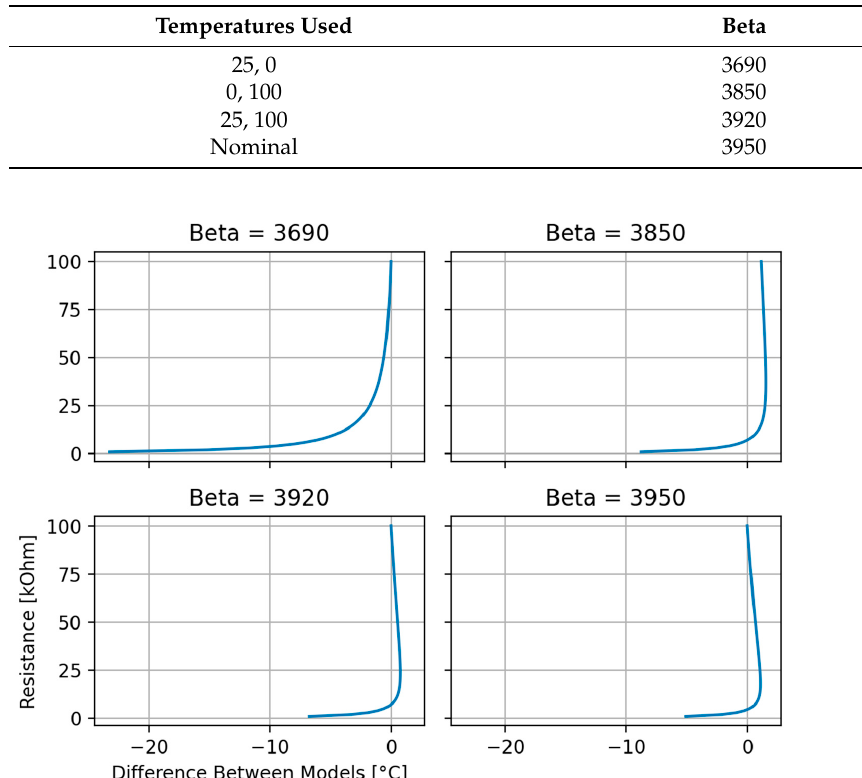
Figure 17. The calculated Beta values have varying accuracy as a function of resistance. These curves show that Beta of 3920 or 3950 maintain an error within 1 ◦ C for the majority of the temperature range under assessment.